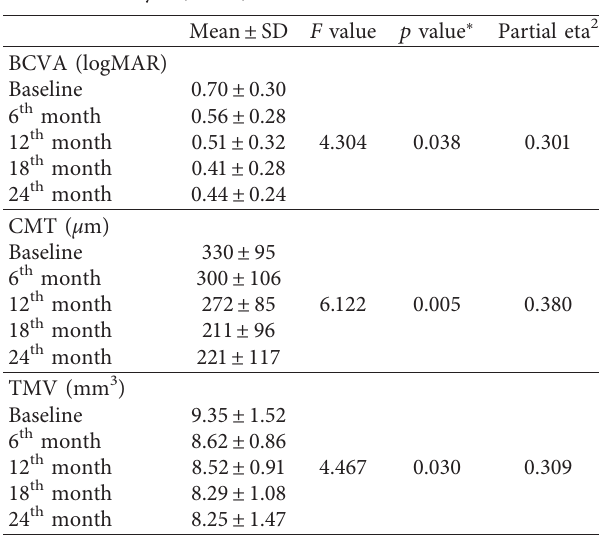
Table 4: Effect of treatment on BCVA, CMT, and TMV values in vitrectomized eyes ( n � 11).